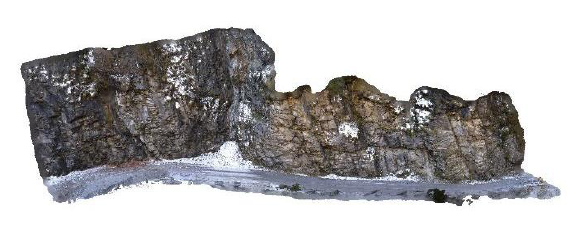
Figure 8. Example of "vertical" terrestrial mesh.